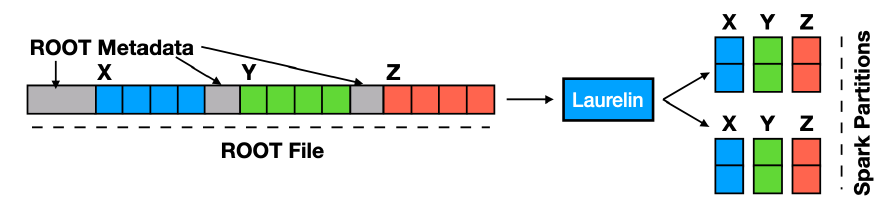
Figure 1. Schema of Laurelin ROOT file’s transformation into Spark